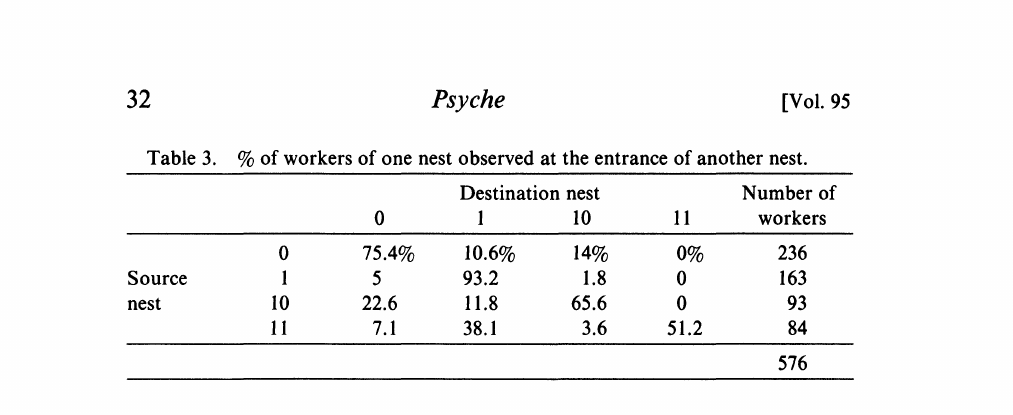
Table 3. % of workers of one nest observed at the entrance of another nest. Destination nest Number of 0 10 11 workers